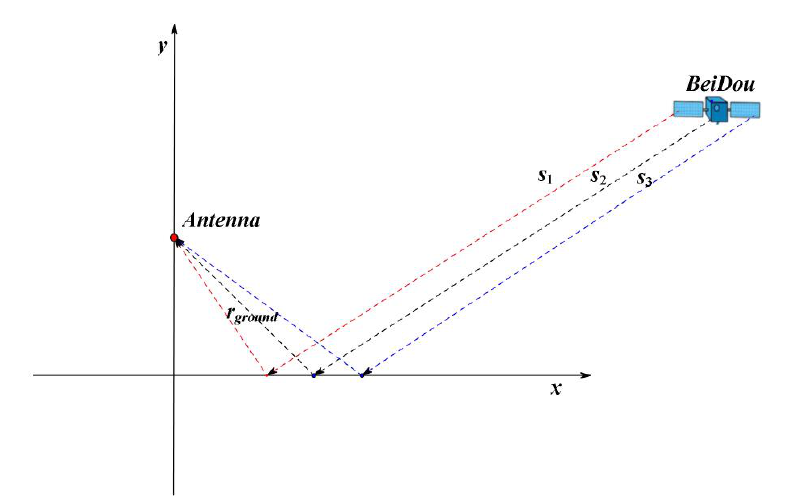
Figure 2. Ground target detection using BeiDou satellite reflected signals when there is no target appearing. s 1 , s 2 , and s 3 are the direct signals of the BeiDou satellite; r ground is the signal reflected by the